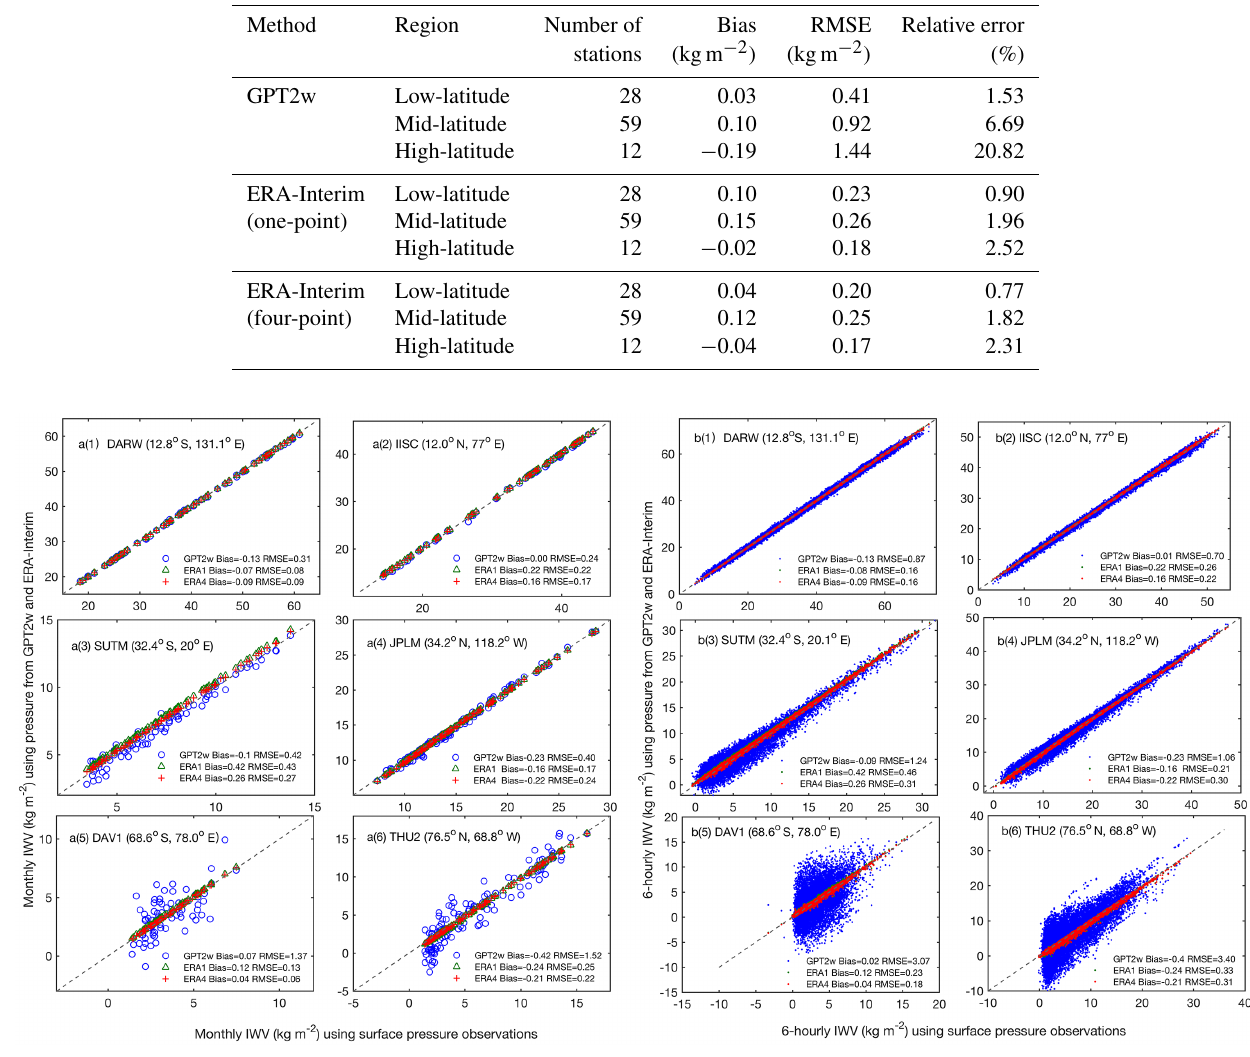
Table 2. Bias, RMSE and relative error of monthly IWV derived from GPT2w and ERA-Interim at 99 stations for the period 2000–2013.